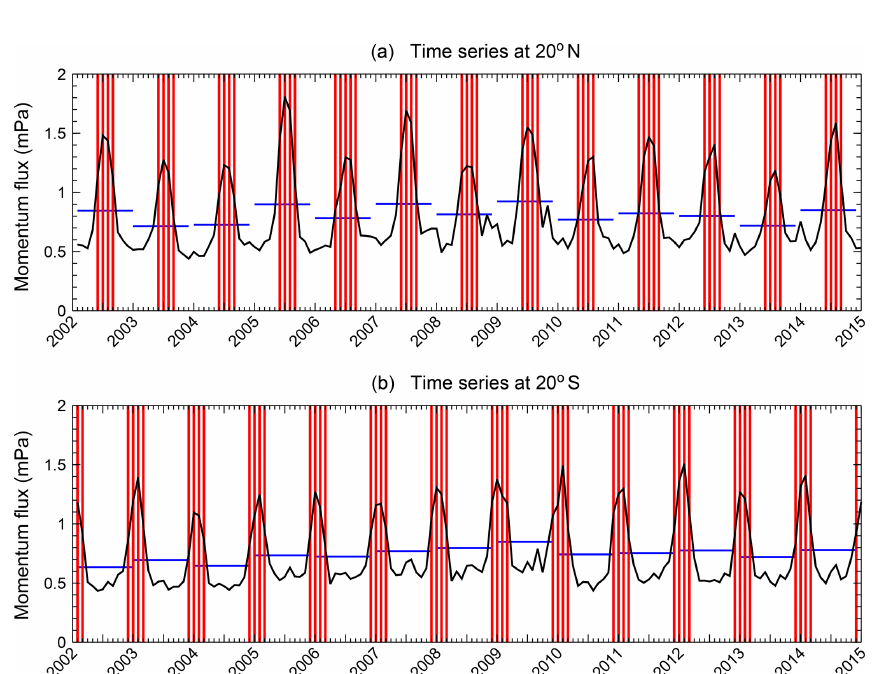
Figure 5. Same as Fig. 2, but for the terannual variation.